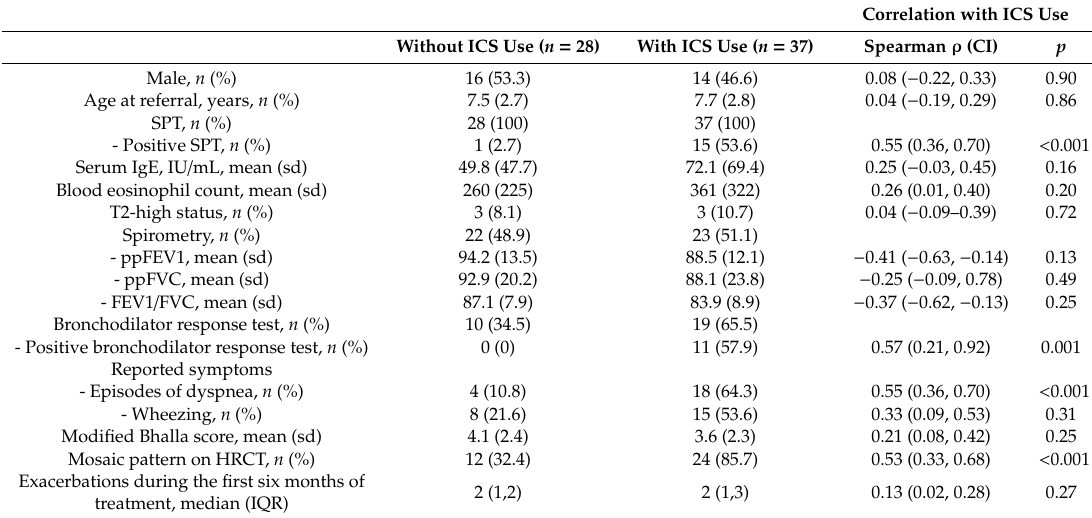
Table 1. Correlations of the main clinical, radiological, and laboratory characteristics of the 65 bronchiectasis patients with inhaled corticosteroids.